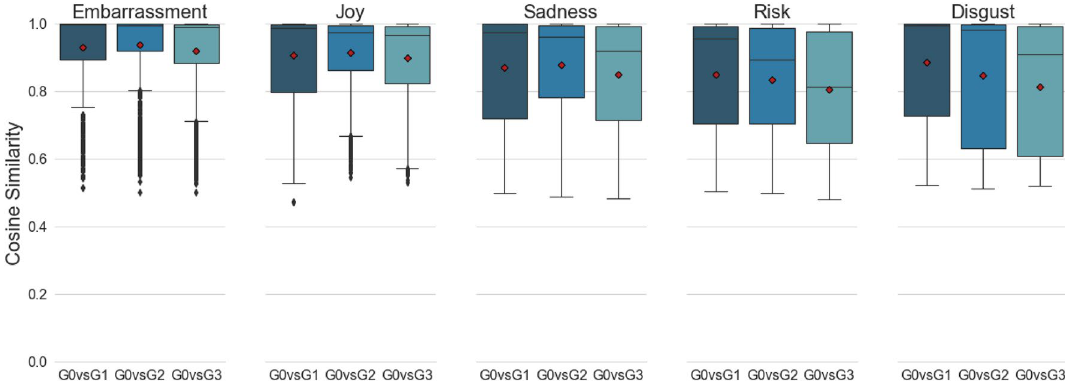
Figure 3. Boxplots of SET1 cosine similarity (CS) scores comparing seed stories to their retold outcomes, across different generations along the serial path of retelling. Individual means are represented by the red diamonds, and outliers are represented by a black point.